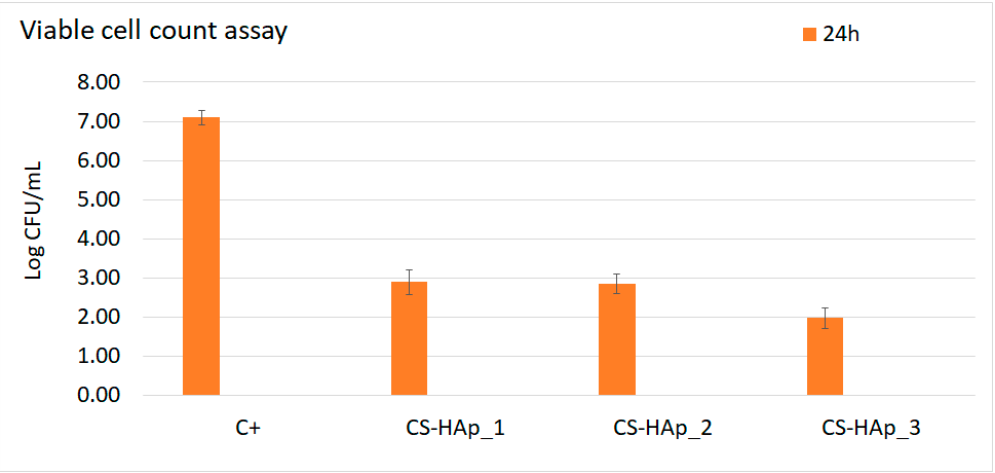
Figure 12. Viable cell count assay of C. albicans fungal strain incubated with CS–HAp composite layers.